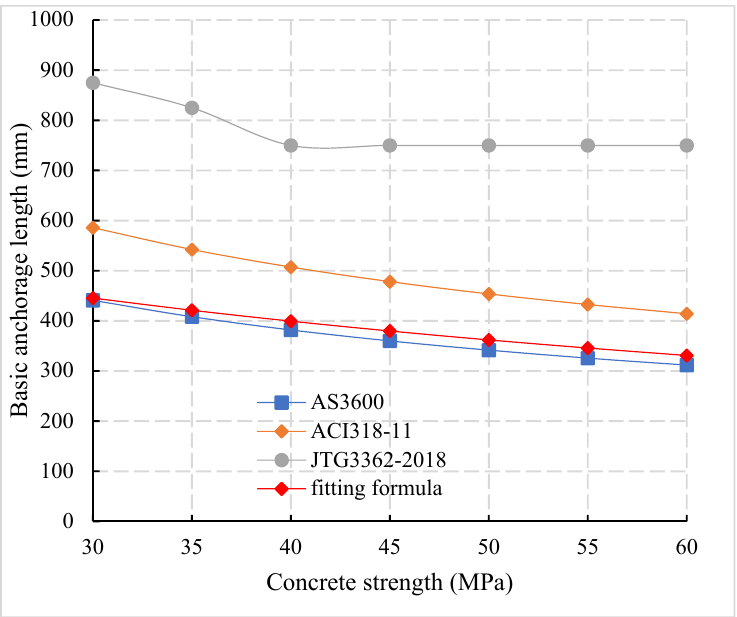
Figure 19. Comparison of calculation of basic anchorage length in domestic and foreign codes. Table 8. Comparison of anchorage length between domestic and foreign codes.